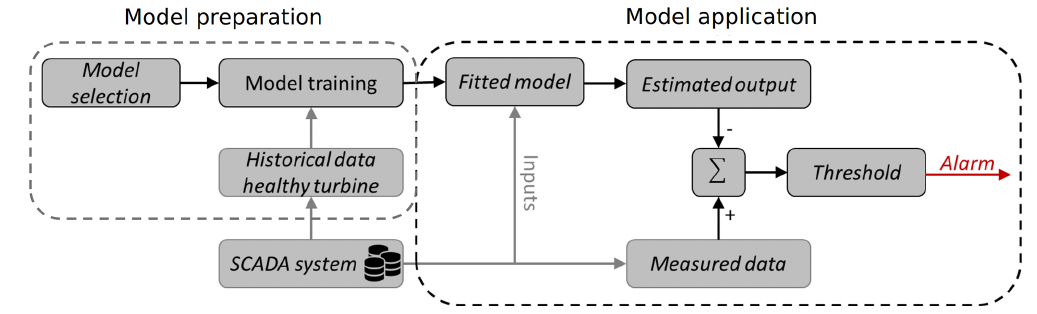
Figure 1. Scheme of normal behaviour model-based anomaly detection with offline model preparation and online